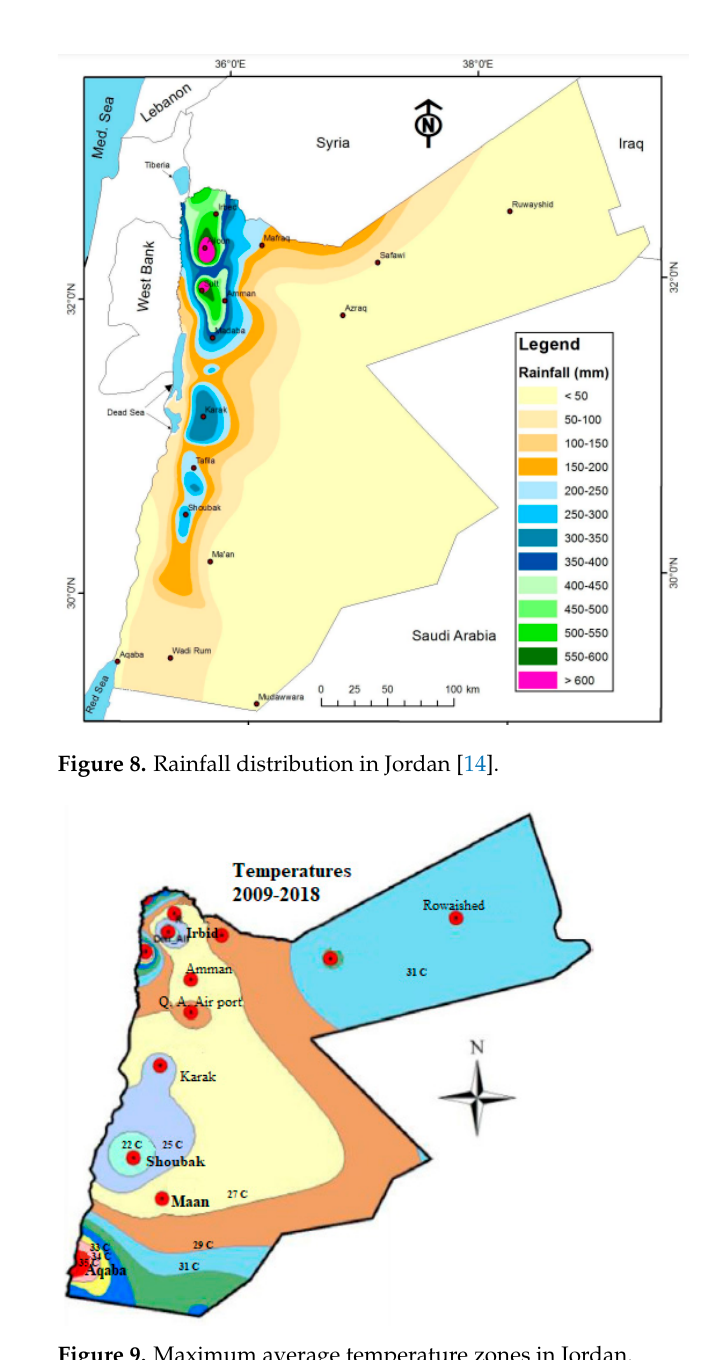
Figure 9. Maximum average temperature zones in Jordan.